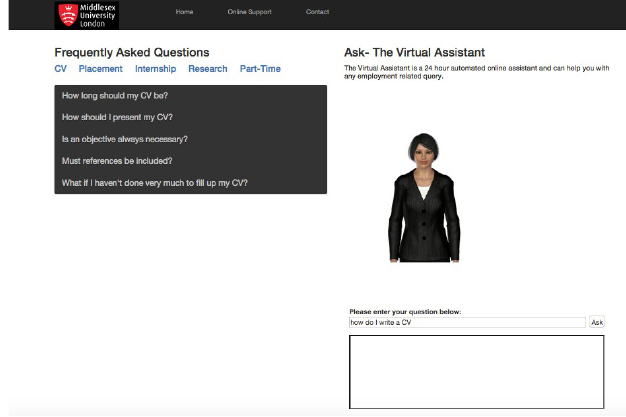
Figure 1. Virtual Assistant